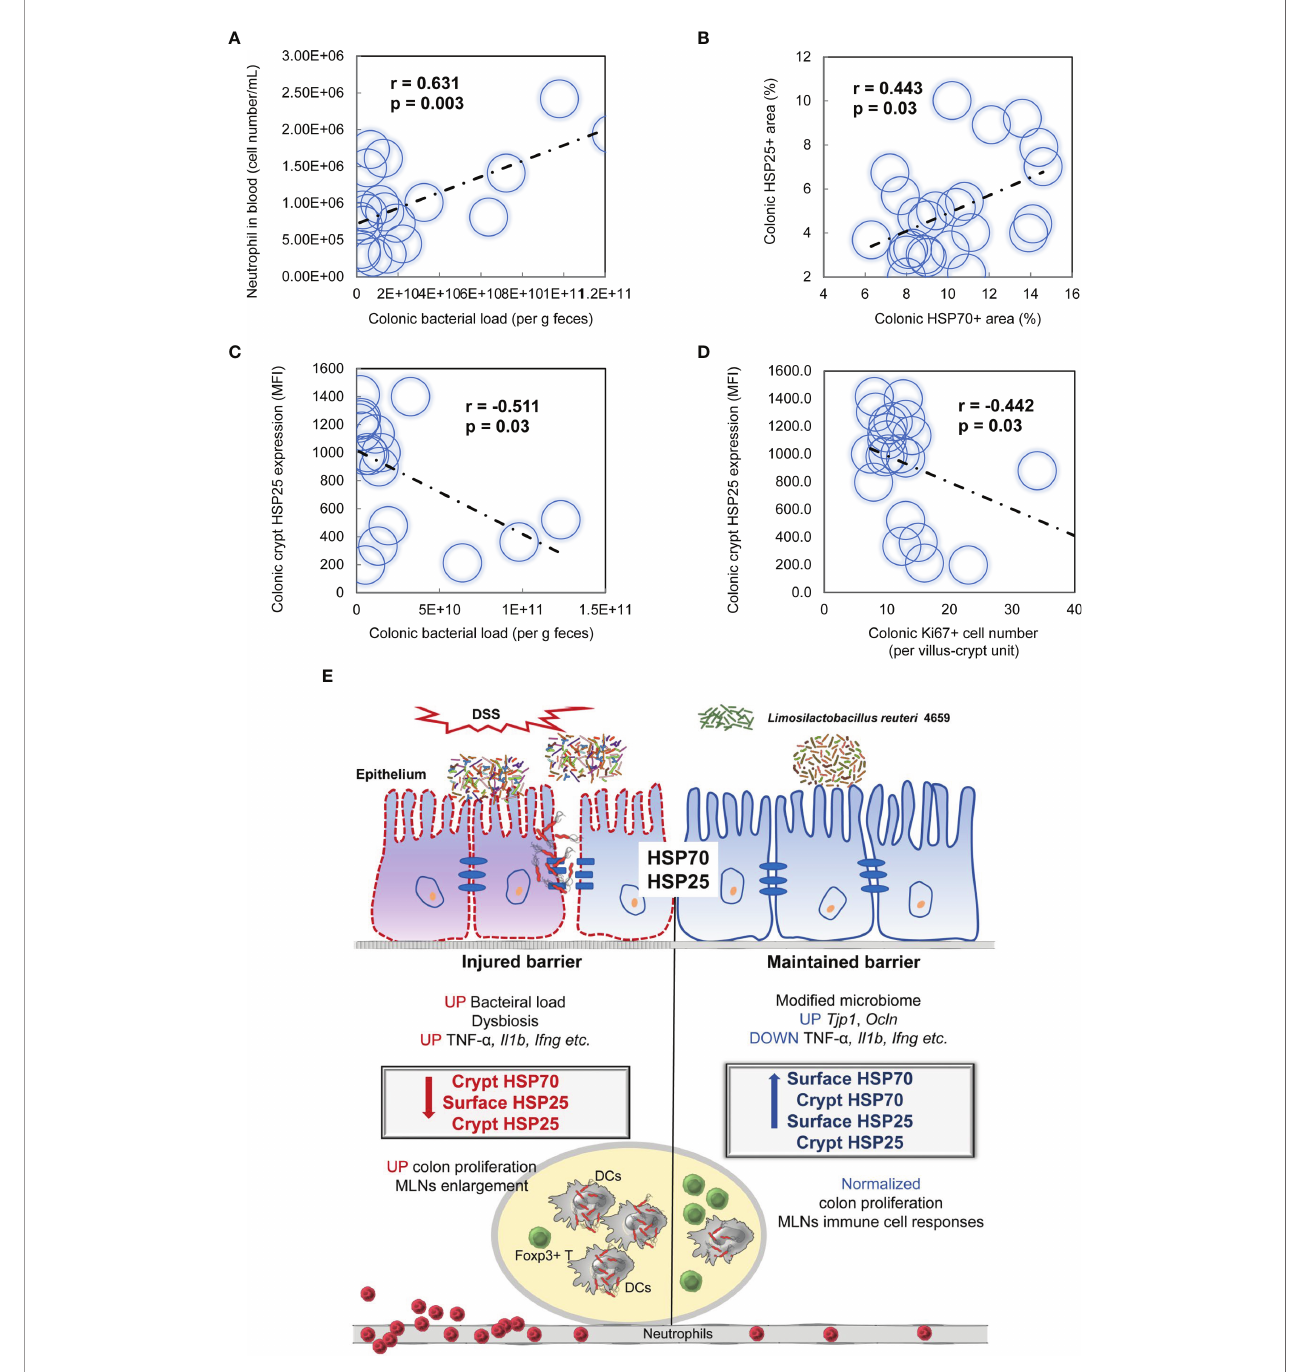
FIGURE 8 | Pearson correlations of the bacterial loads, parameters of immune responses, and the expression of heat shock proteins (HSPs) in the colon within animals were conducted in response to L. reuteri during DSS-induced colitis in young mice ( A – D , n = 24). (E) Schematic illustration of epithelial HSP-mediated protective effects of L. reuteri ATCC PTA 4659 during established colitis. DSS, dextran sulfate sodium; DCs, dendritic cells; MLNs, mesenteric lymph